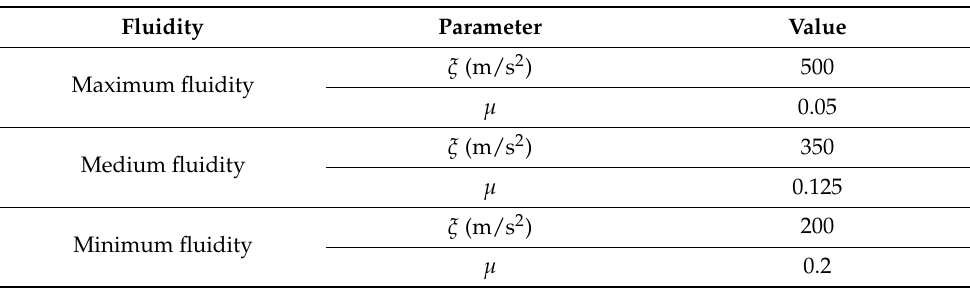
Table 1. Values considered for flow-type landslide mathematical models with variation in the state of fluidity. Source: values from